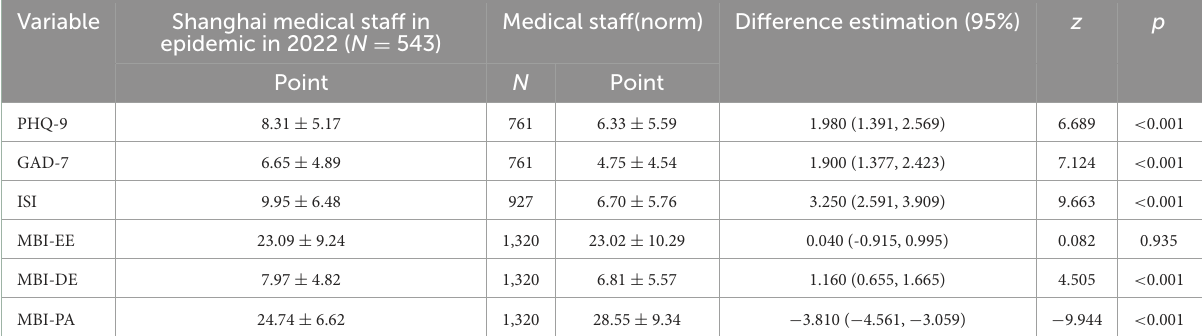
TABLE 3 Comparison of job burnout, mental health and sleep status of medical workers in Shanghai with the norm (x ± s, n = 543).